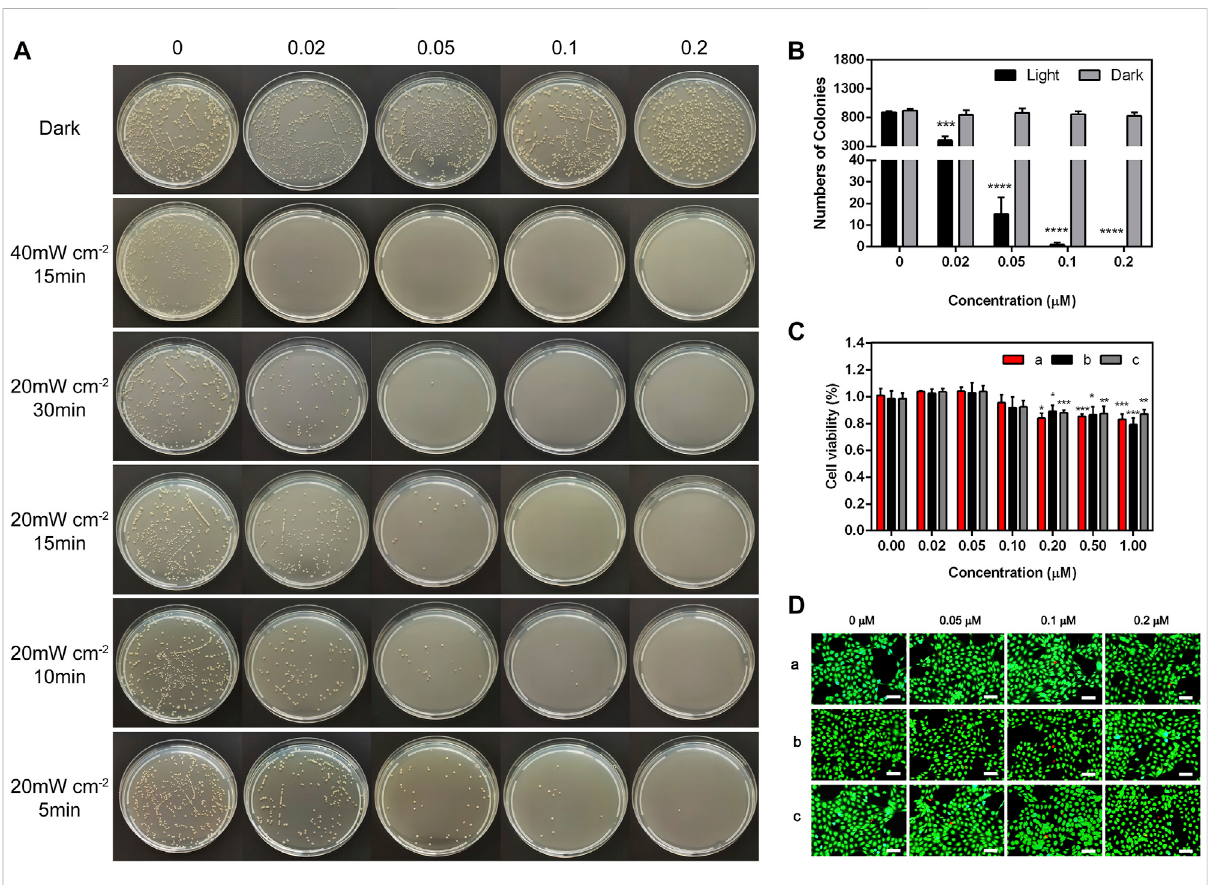
FIGURE 2 (A) Representative photographs of S. aureus treated by TTVP at different concentrations and irradiation conditions. (B) The surviving colony countof S.aureus treatedbyTTVPinlightcondition(20 mW/cm 2 )for15 min. (C,D) CellviabilityandLive/deadstainingimagesofHCECstreatedwith TTVP, (a) with light after incubation with TTVP for 15 min and (b) without light after incubation with TTVP for 15 min (c) treated by TTVP for 24 h without light (scale bar: 100 μ m). *for comparison among different concentrations of TTVP (0.02, 0.05, 0.1, 0.2, 0.5 and 1 μ M) versus TTVP